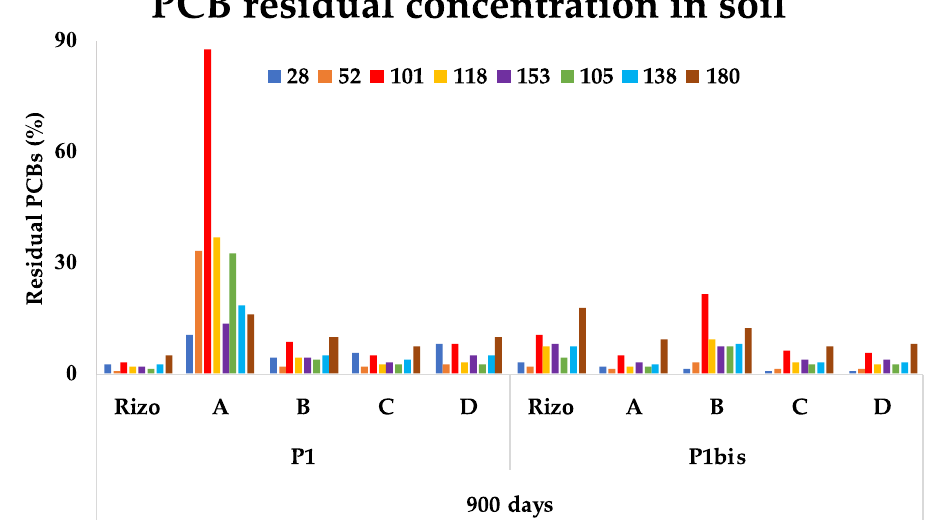
Figure 3. Residual percentages (%) of the various PCB congeners in soils sampled at different distances and depths from the trunk 900 days after poplar planting in the P1 and P1bis plots. Rizo: soil attached and surrounding roots, 0–30 cm depth; A: 0.25 m distance from the trunk and 0–20 cm depth; B: 0.25 m distance from the trunk and 20–40 cm depth; C: 1 m distance from the trunk and 0– 20 cm depth; D: 1 m distance from the trunk and 20–40 cm depth. The percentages were calculated in relation to the initial concentration reported in Table 3.